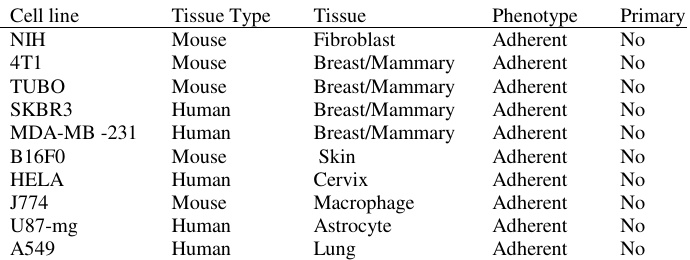
TABLE 1: Cancer cell lines and normal cell line data in this study Table 1. Cancer cell lines and normal cell line data in this study Cell